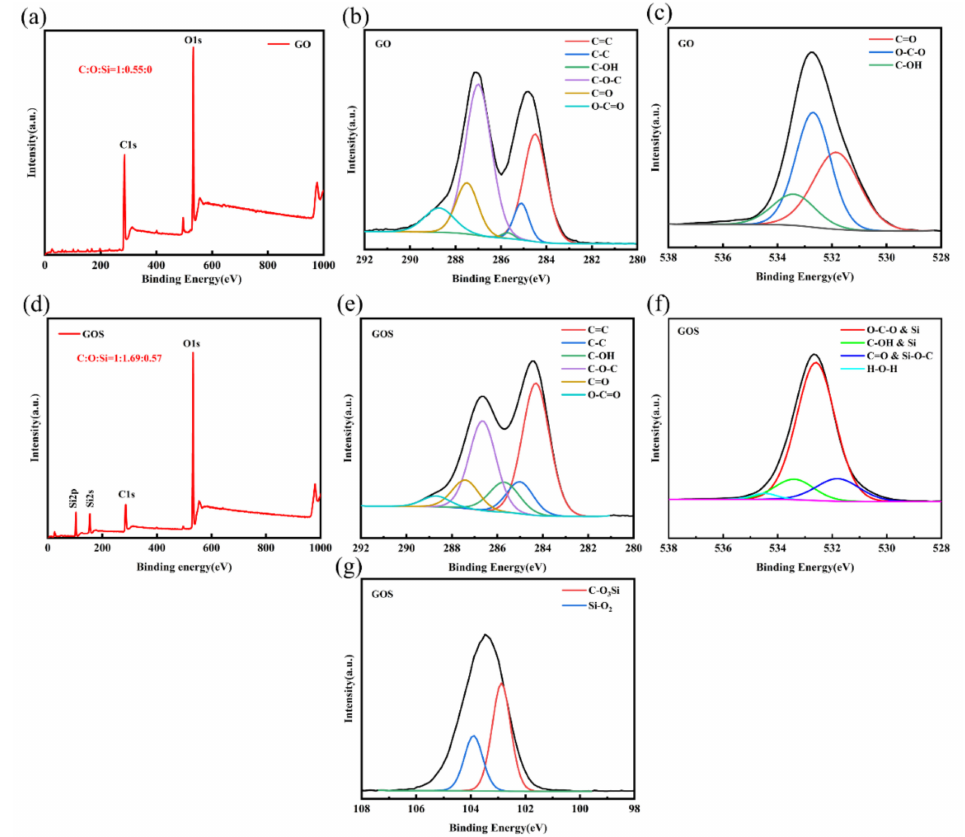
Figure 3. The XPS characterization spectra: ( a ) The GO full spectrum. ( b ) The GO C1s deconvolution peak. ( c ) The GO O1s deconvolution peak. ( d ) The GOS full spectrum. ( e ) The GOS C1s deconvolution peak. ( f ) The GOS O1s deconvolution peak. ( g ) The GOS Si2p deconvolution peak. The XRD diffraction diagram of GO and GOS is shown in Figure 4a. GO has a signifi- cant diffraction peak when 2 θ is 10.99 ◦ , corresponding to the (001) graphite oxide phase, consistent with the literature [25]. The synthesized interlayer spacing of GO is 0.804 nm, indicating that many oxygen-containing functional groups have been inserted into the interlayer of graphite with severe oxidization. In the XRD diffraction diagram of GOS, the angle of the characteristic diffraction peak for GO has shifted from 10.99 ◦ to 11.89 ◦ . This shift is because the dehydrating condensation of the hydroxyl and carboxyl groups on the TEOS with GO prevented GOS from re-stacking. Furthermore, due to a load of amorphous silica particles, a wide peak appeared when 2 θ = 22.72 ◦ for the GOS image in Figure 3c.